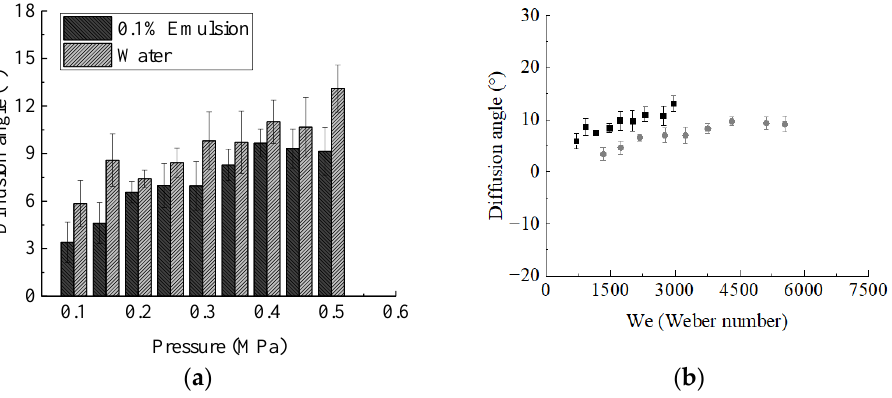
Figure 8. ( a ) Diffusion angle of two fragmentation mechanisms varies with pressure. ( b ) Diffusion angle varies with Weber number. The concentration of emulsion is 0.1%. The black symbols are diffusion angles under high surface tension and the grey symbols for low surface tension.